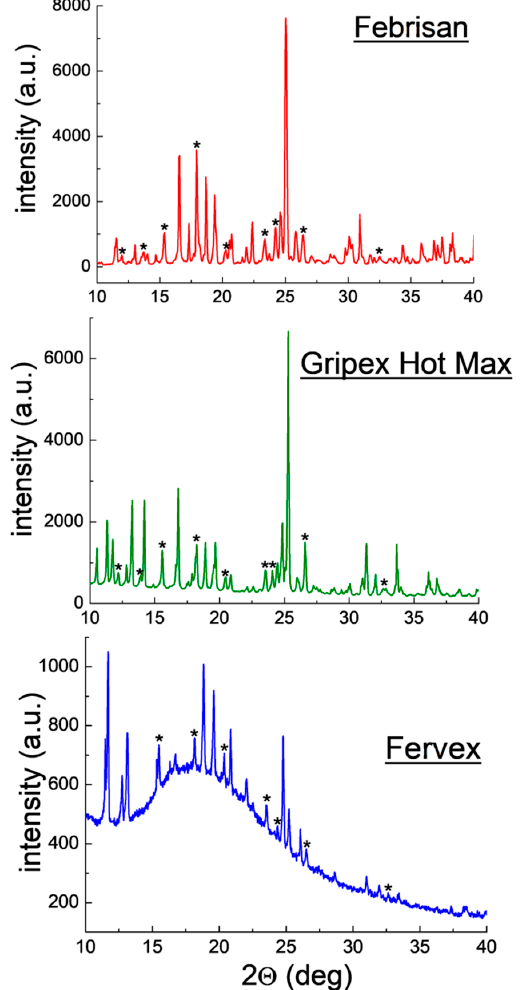
Figure 8. Diffraction patterns for the drugs Febrisan, Gripex Hot Max and Fervex. Figure 8. Di ff raction patterns for the drugs Febrisan, Gripex Hot Max and Fervex.